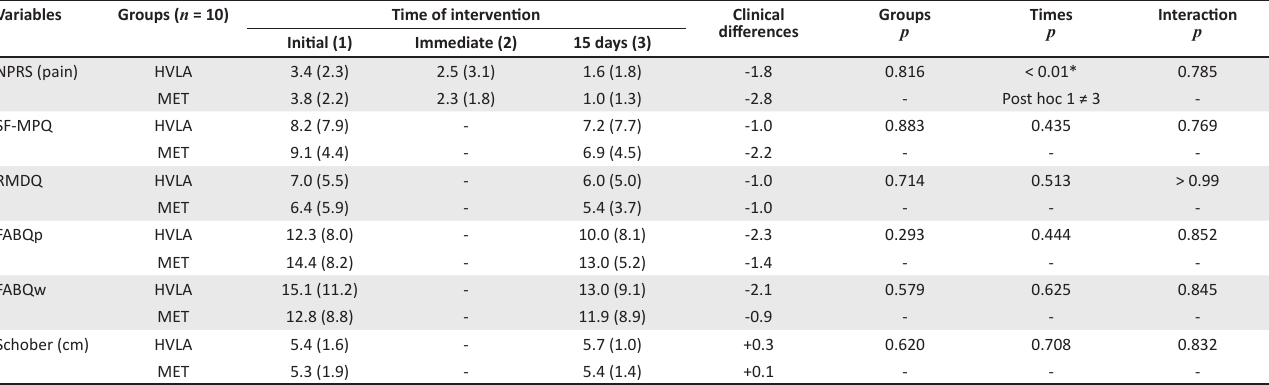
TABLE 1: Effect of interventions (high-velocity low-amplitude thrust manipulation and muscle energy technique) on clinical variables from initial time (1 = pre-intervention); immediate (2 = post-immediate intervention on first day); and after 15 days (3 = post-final intervention). Variables Groups ( n = 10)